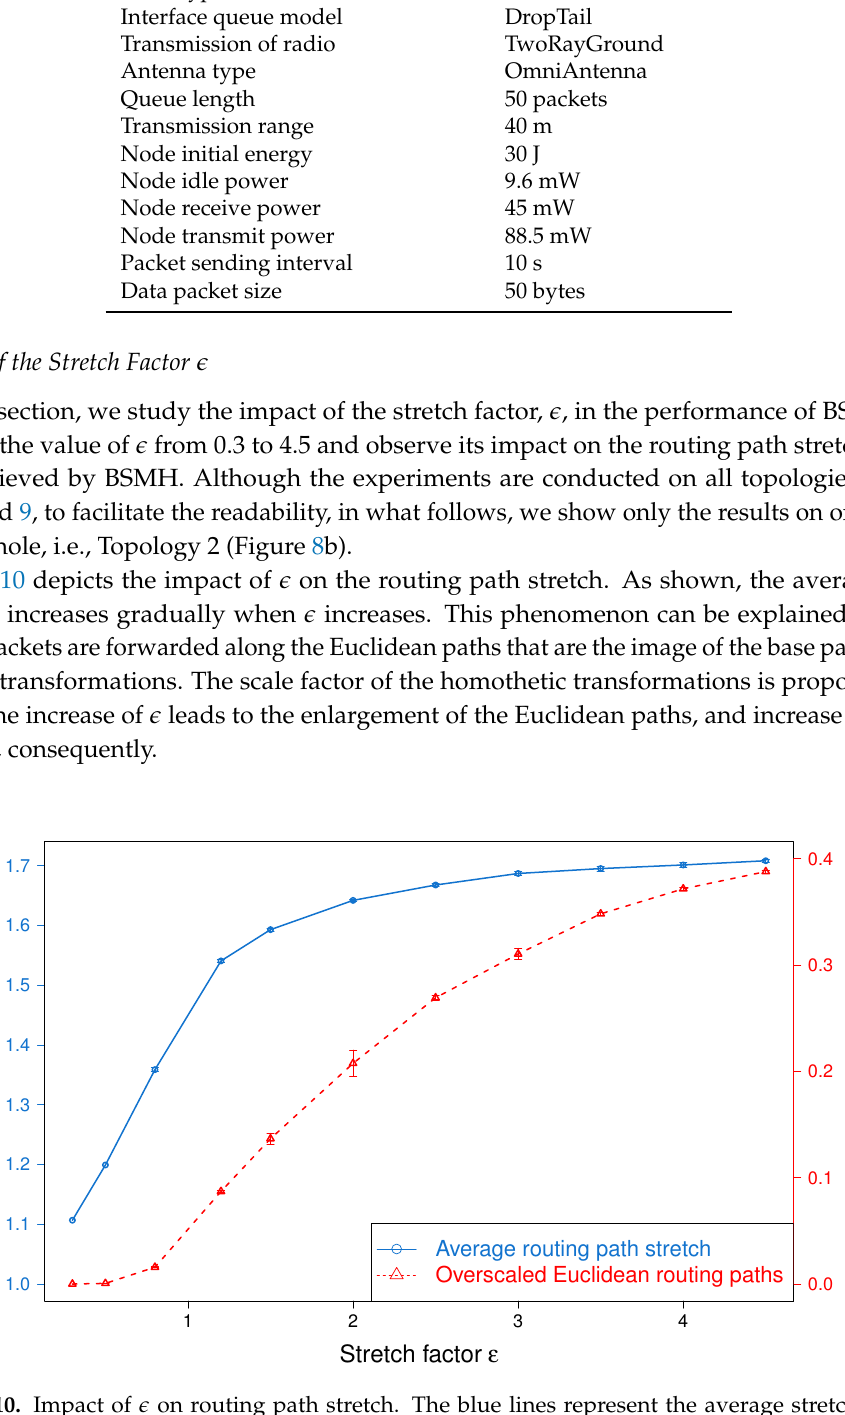
Figure 10. Impact of (cid:101) on routing path stretch. The blue lines represent the average stretch of all routing paths, the red lines represent the percentage of Euclidean routing paths that exceed the network